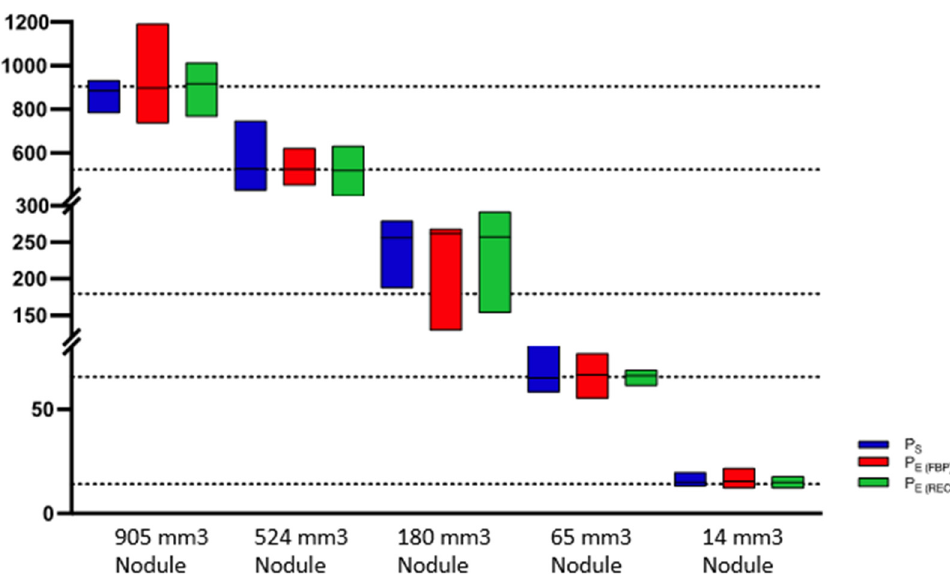
Figure 4. Box-plot diagram of mean ± SD volume measurements of various nodules sizes (905, 524, 180, 65, 14 mm 2 ) among all protocols for all scanners included. P S = Standard Protocol, P E(FBP) = ESTI Protocol with filtered back projection reconstruction algorithm applied, P E(REC) = ESTI Protocol with conventional reconstruction.